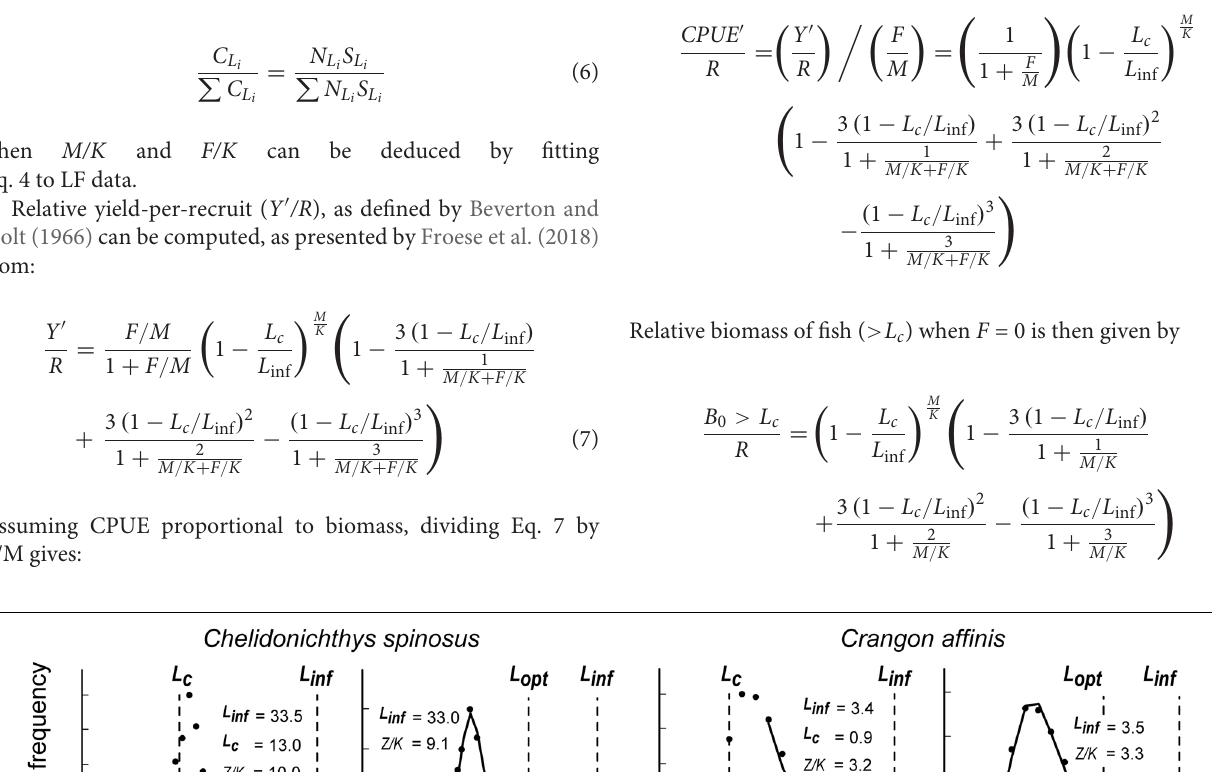
Frontiers in Marine Science |